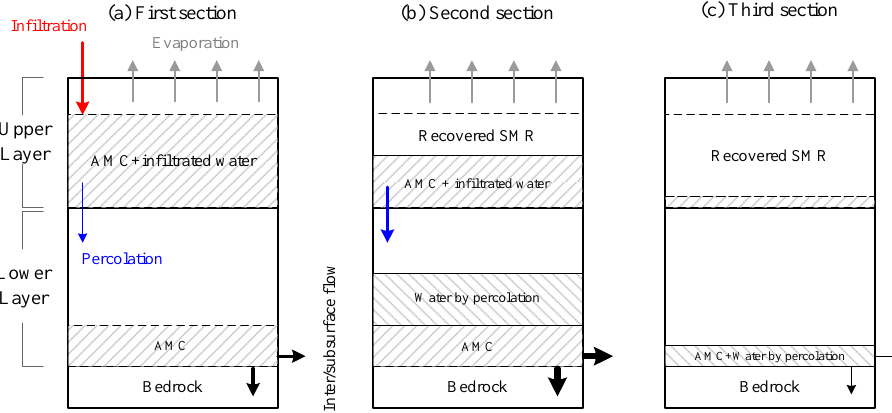
Figure 12. Conceptual diagram of soil column water movement depending on the specified section by the recovery rate: In this figure, AMC indicates the antecedent moisture content and the thickness of arrows denotes the magnitude of the process. It is assumed that evaporation is constant for the short-term interval with no rain: ( a ) Hydrological processes in a soil column at the first section; ( b ) at the second section; and, ( c ) at the third section.